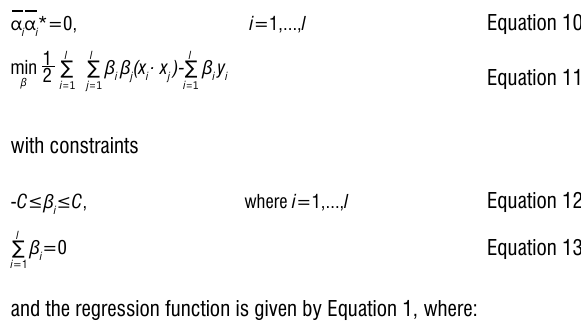
Figure 1: A map showing the location of the 3.068-ha area sampled in southern Nigeria.